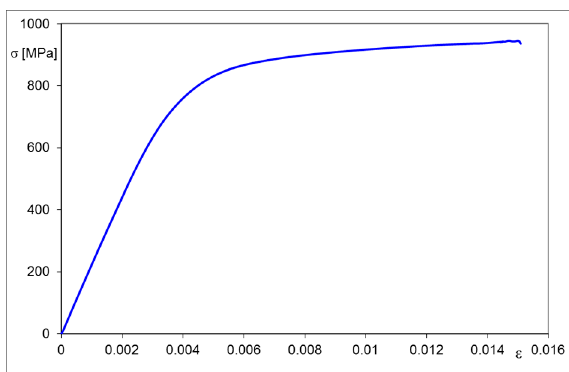
Figure 1. Stress–strain relationship of annealed X20Cr13 steel subjected to tensile test.